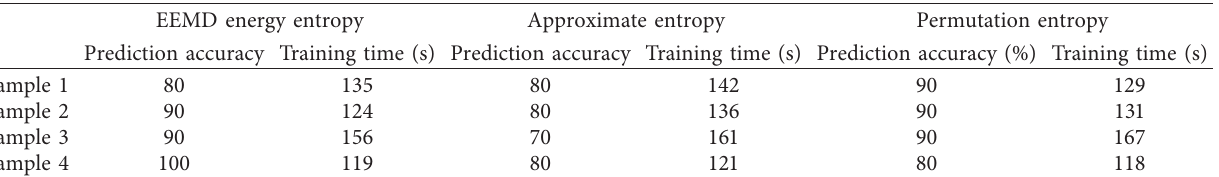
Table 8: Algorithm effect